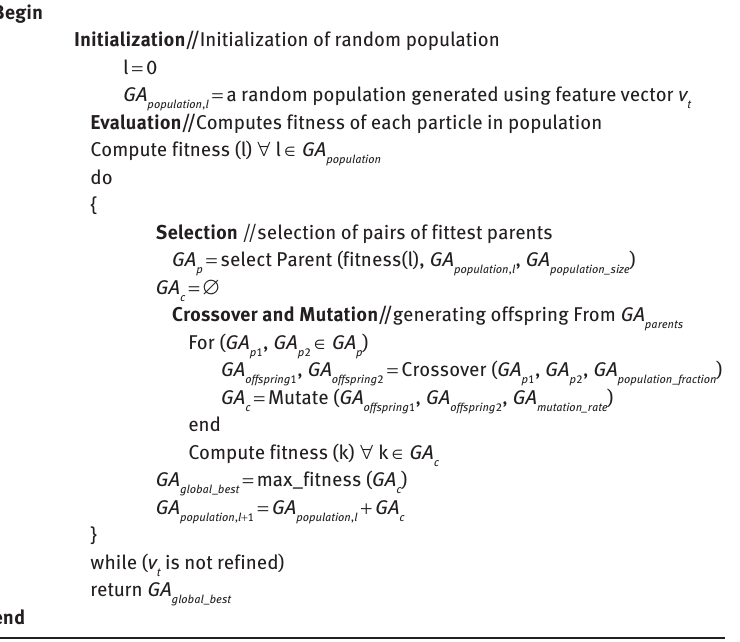
, GA population_size population_fraction